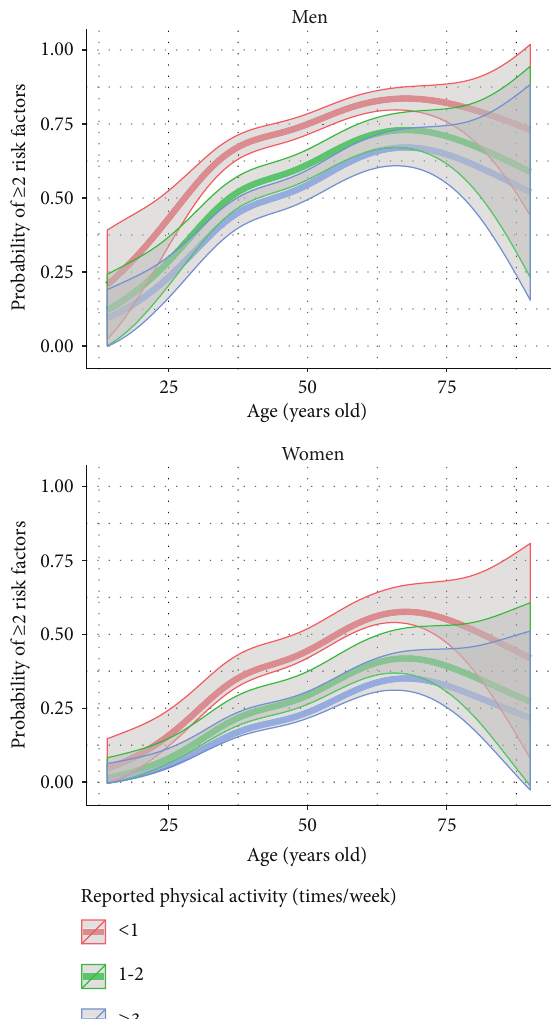
Figure 2: Odds proportional models showing the probability of presenting ≥ 2 risk factors according to self-reported physical activity and age in men and women.